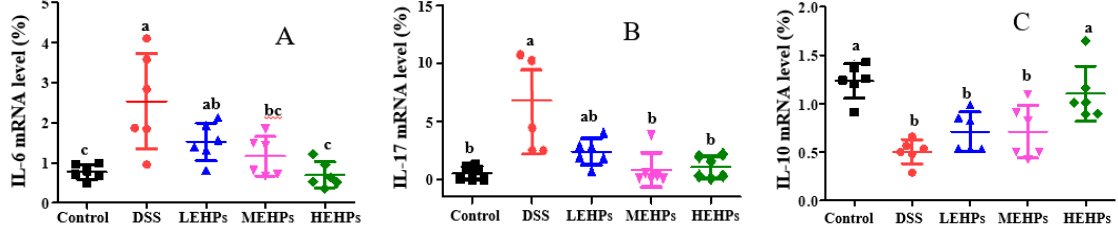
Figure 6. Effect of EHPs on the pro-inflammatory and anti-inflammatory cytokines in colonic tissue. ( A , B ) Pro-inflammatory cytokines (IL-6 and IL-17) in colonic tissue. ( C ) Anti-inflammatory cytokines (IL-10) in colonic tissue. The letters (a–c) indicate the significant differences of all treatment groups ( p < 0.05).